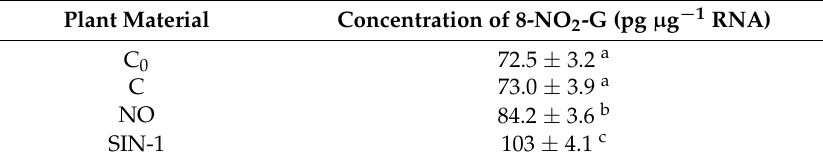
Table 1. RNA nitration measured as concentration of 8-NO 2 -G (pg · µ g − 1 RNA) in axes of apple embryos isolated after 24 h of seeds imbibition in water (C 0 ), in axes of embryos imbibed in water for 3 h after seed coat removal (C), in axes of embryos fumigated with NO for 3 h (NO), quantification of nitrated RNA measured as 8-NO 2 -G concentration in embryos isolated from seed coat after treatment with 0.3 mM SIN-1 in light conditions for 3 h